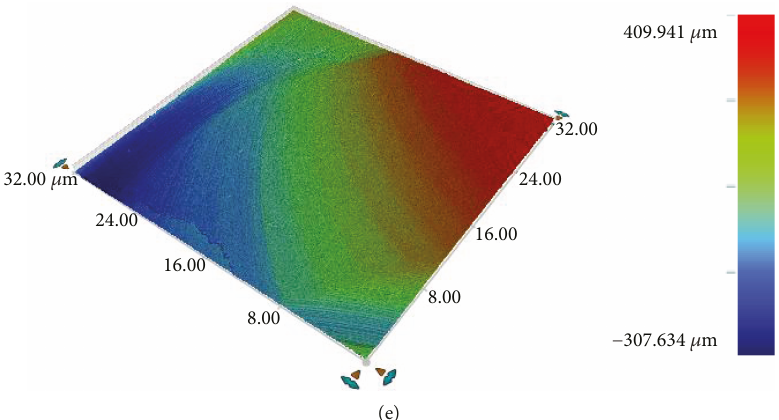
Figure 4: Typical morphology of the fracture surface: (a) CI, (b) CII, (c) CIII, (d) GHI, and (e) GHII.